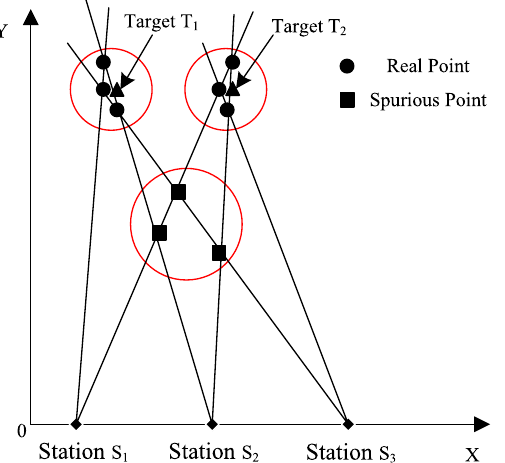
Fig. 3 Distribution of intersections for three observation stations and two radiation